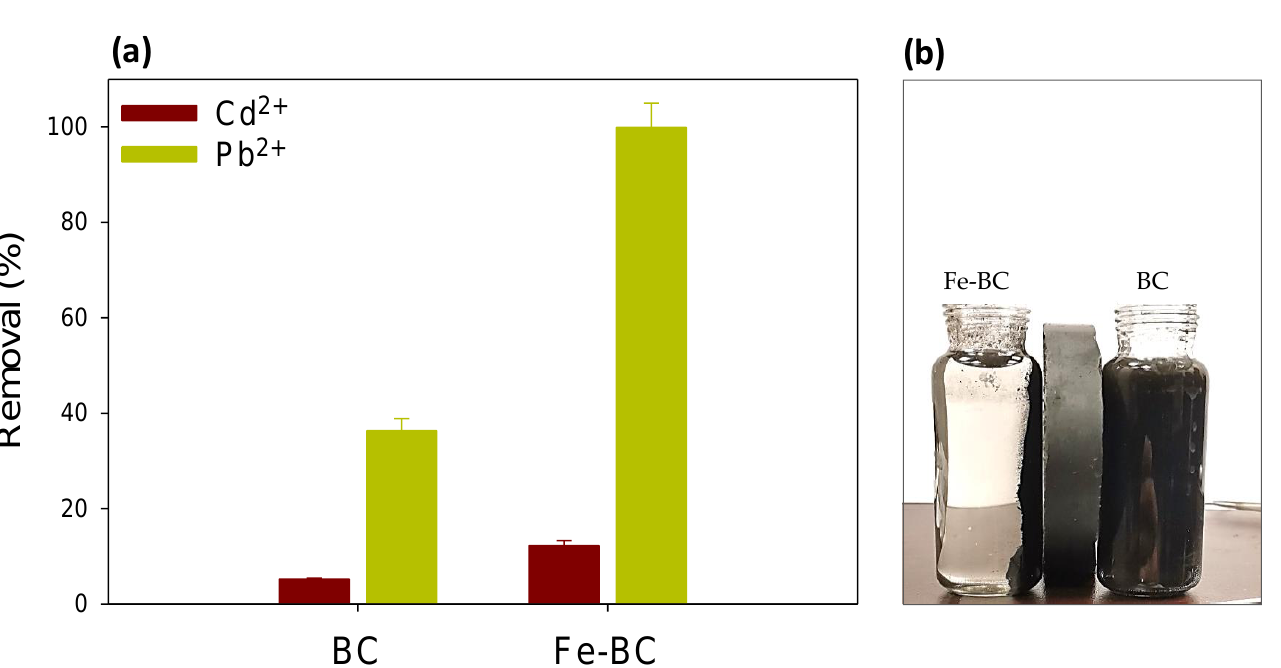
Figure 5. ( a ) Competitive removal of cadmium (Cd 2+ ) and lead (Pb 2+ ) ions from binary solution on date palm waste biochar (BC) and Fe-modified biochar (Fe-BC), ( b ) attraction of BC and Fe-BC materials to the applied magnetic force.